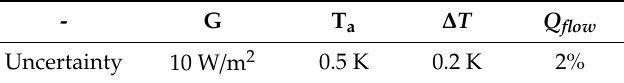
Table 2. ISO 9806 standard sensor uncertainty.